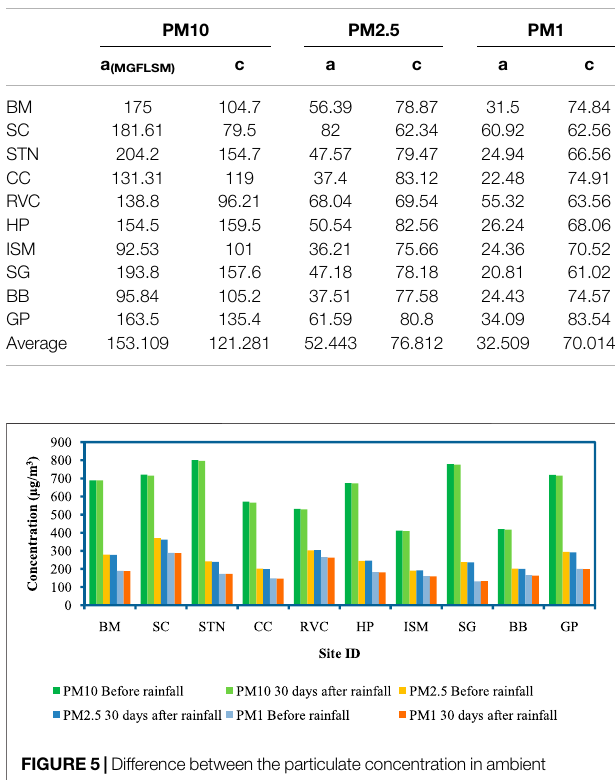
TABLE2| Coef fi cientsofthelogarithmictermandtheinterceptofthesite-speci fi c relationshipbetweenparticulateconcentrationinambientairandtimeelapsed after rainfall.